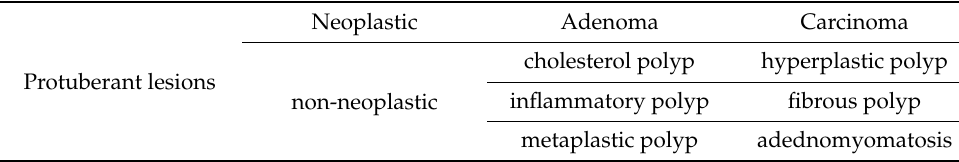
Table 1. Classification of GB protuberant